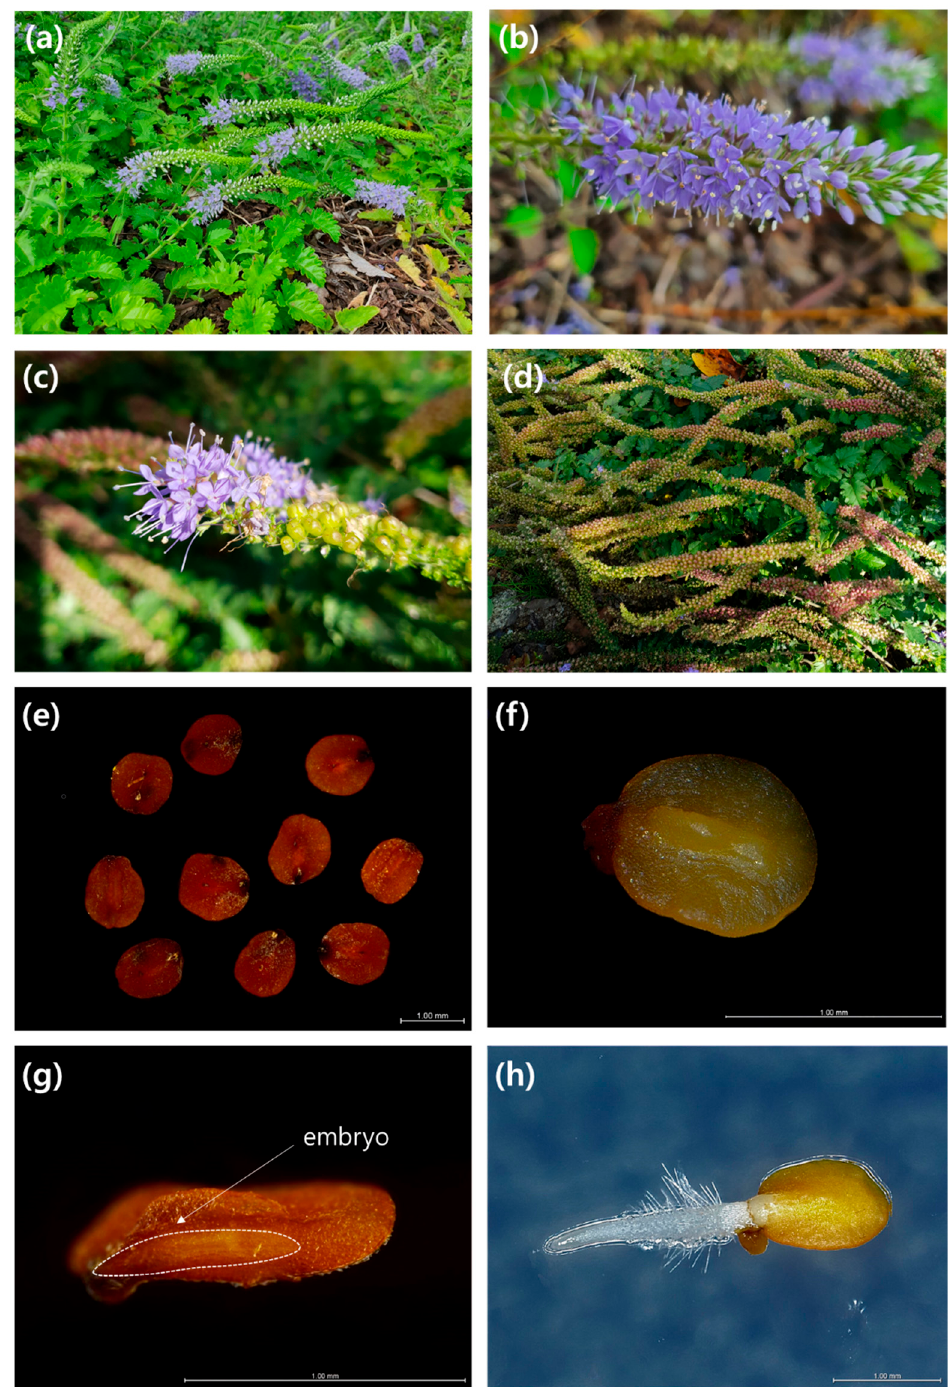
Figure 1. Morphology of Pseudolysimachion pusanensis (Y. N. Lee) Y. N. Lee. ( a ) A field of P. pusanensis at Bonghwa-gun. ( b ) Flowers on the basal inflorescence bloomed on 3 August, 2019. ( c ) Flowers on the distal inflorescence bloomed on September 30, 2019. ( d ) The seed color in the ovaries varied from green to brown on October 20, 2019. ( e ) Seeds at dispersal. ( f ) Digital image of a seed. Cross-section of a seed showing ( g ) an undeveloped embryo and ( h ) radicle emergence; scale bar = 1 mm (applies to ( e – h )).